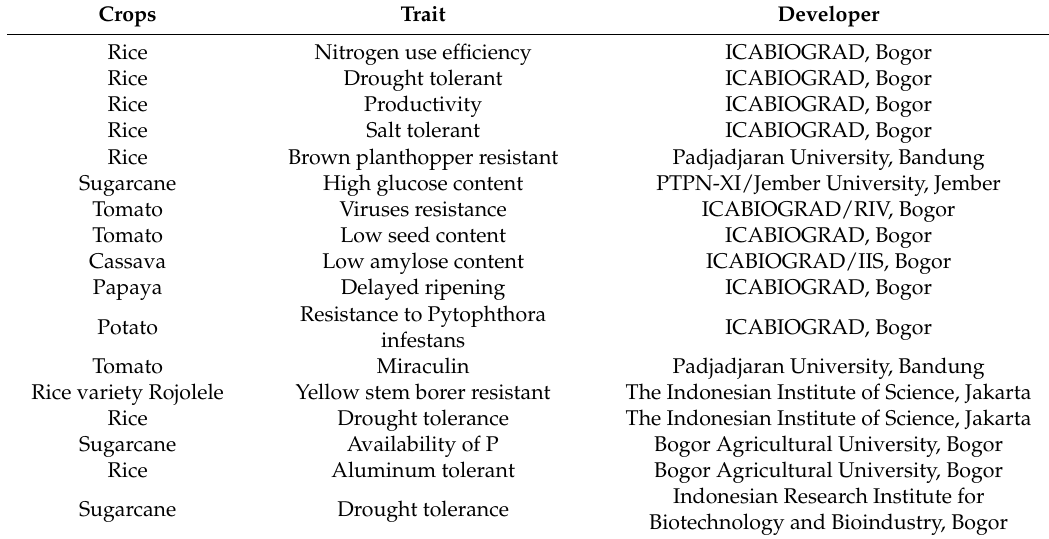
Table 1. GMO crops in